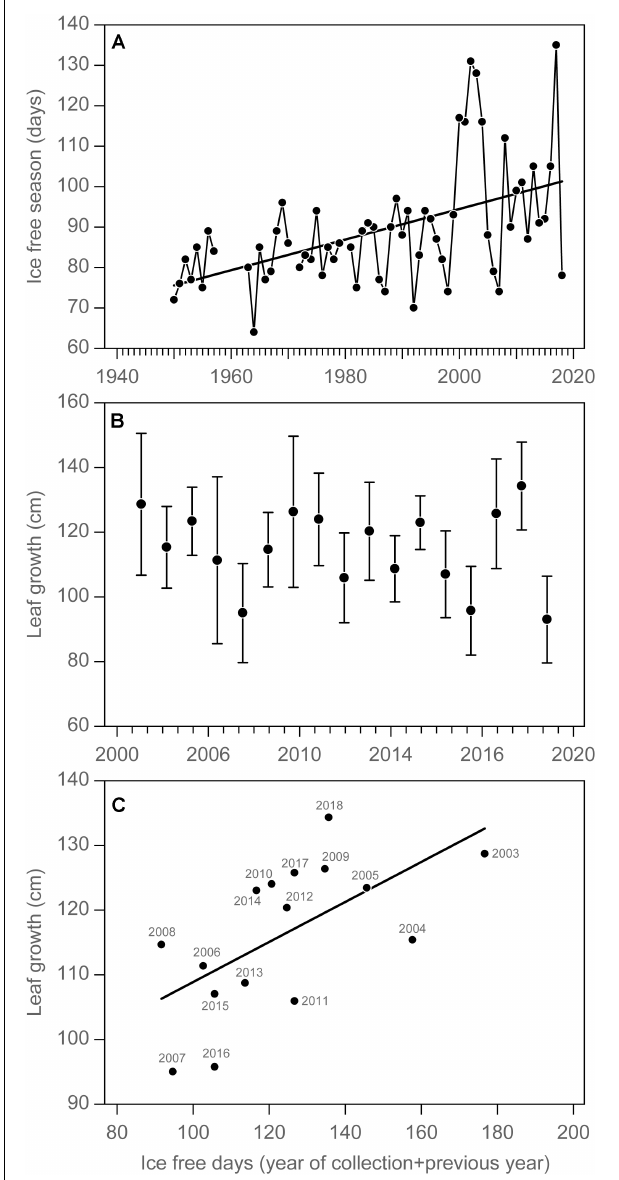
FIGURE 4 | Time series of kelp growth in relation to climate change in Young Sound, NE Greenland 74 ◦ N. (A) Changes in the duration of the ice free season in outer Young Sound over the period 1950–2019. (B) Average leaf length growth ( ± 95% CI) of Saccharina latissima at 10 m depth in Young Sound over the period 2003–2019. (C) Relationship between leaf growth and ice-free season of the year of growth and the previous year. Data from the Greenland Ecosystem Monitoring Program “MarinBasis